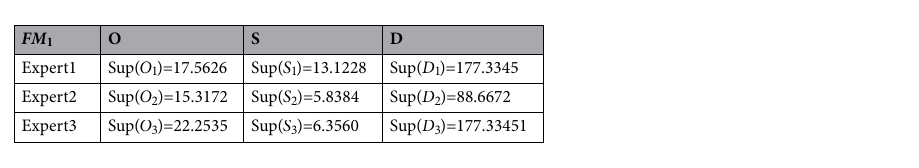
Table 6. The support degree of risk factors in FM 1